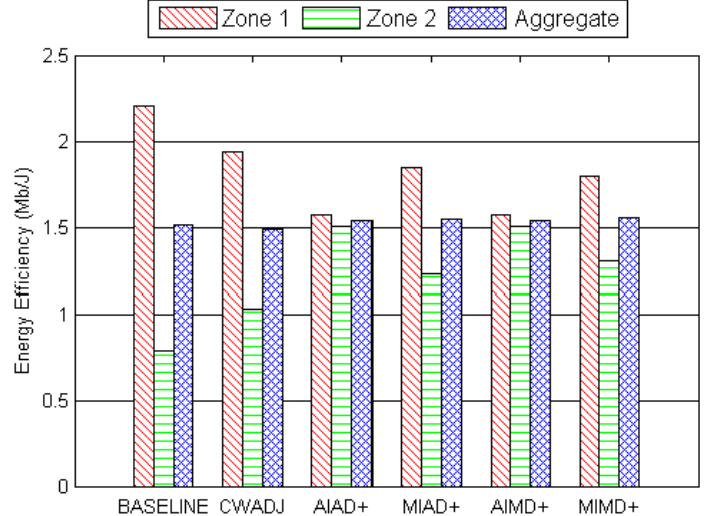
Figure 9. Comparison of three proposed strategies with the